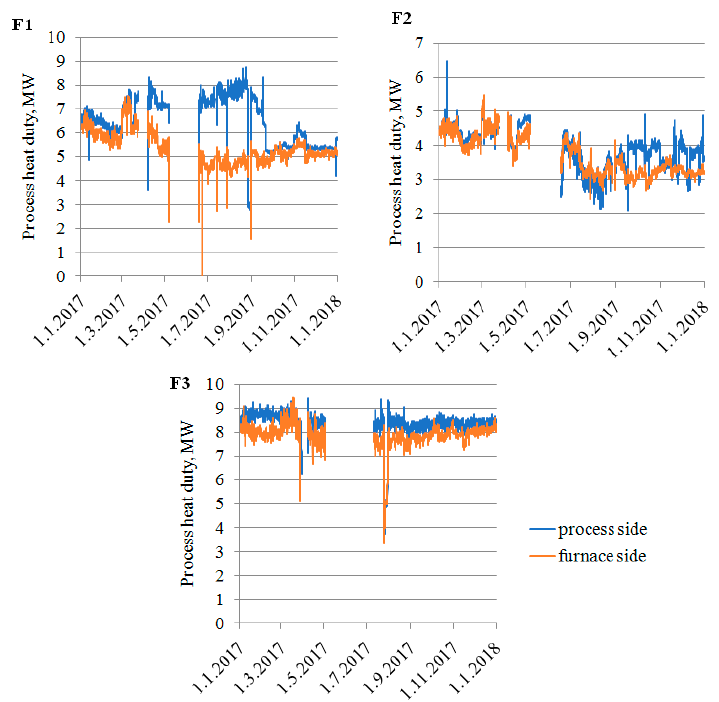
Figure 6. Process heat duty calculation verification for furnaces F1 to F3. Legend: F1 = furnace 1; F2 = furnace 2; F3 = furnace 3. Furnaces location in the process is shown in Figures 3 and 4.